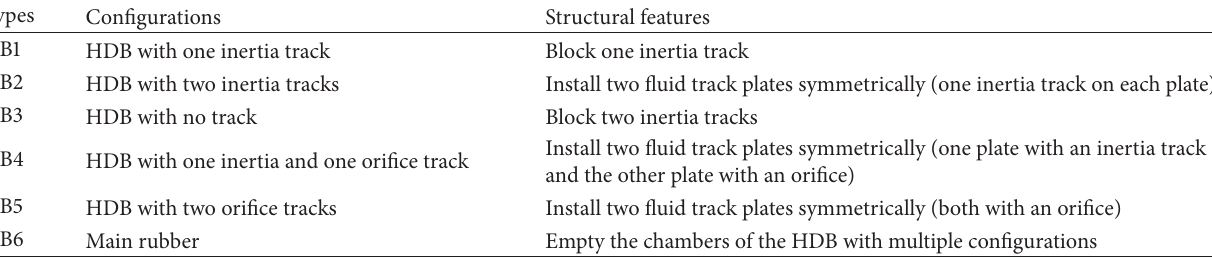
Table 2: The configurations of HDB samples.